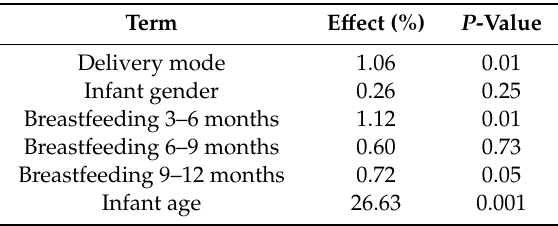
Table 1. Maternal and infant factors associations to operational taxonomic units (OTUs). The table shows the e ff ect (%) and p-value for delivery mode, gender, and breastfeeding, between 3 and 6 months, 6 and 9 months, and 9 and 12 months, and infant age from 0–12